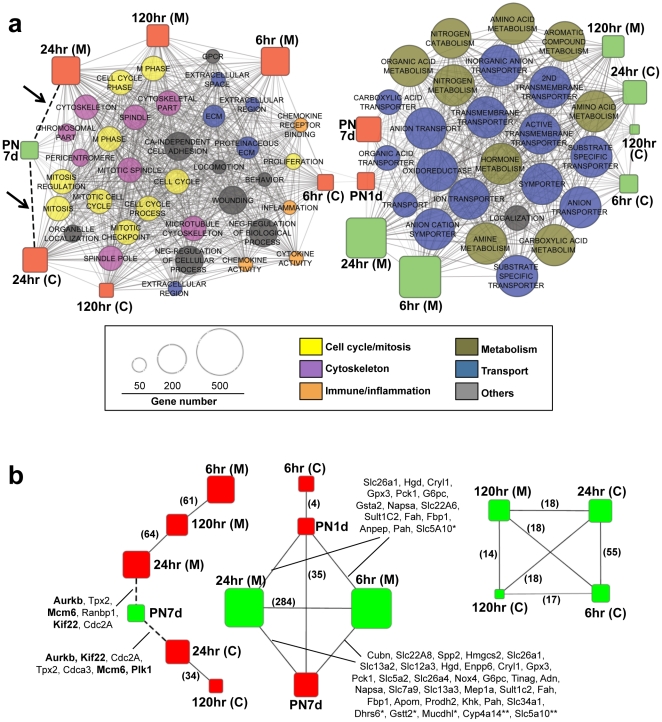
Functional association network.
A. The differentially expressed genes during regeneration or development of kidney (the up- and down-regulated genes as red and green rectangles, respectively) and GO categories (circles) are shown as nodes. The significant enrichment between two gene sets is shown as edge between two corresponding nodes. The size of node is proportional to the gene size and GO categories were classified into six major functions as shown in the color scheme. Two dashed lines with arrows represent the significant association between PN7d (genes down-regulated compared to E16d) and 24 hr I/R (genes up-regulated compared to sham). B. The significant associations between gene sets are shown after removing GO categories. The overlapping genes are shown for pairs between I/R injury and development. Experimentally validated four genes are bold. * and ** represent the genes only observed with 6 hr/medulla and 24 hr/medulla, respectively. Number of overlapping genes are shown in parenthesis for significant pairs between I/R injury gene sets.